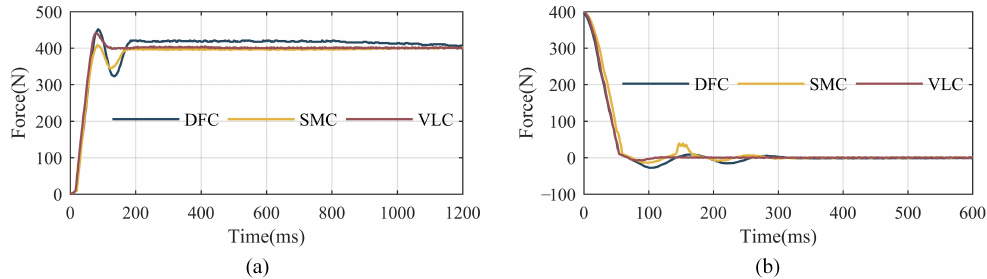
Figure 11. The response curves of step signal with different control strategies. ( a ) Response curves when the target force is 400 N; ( b ) response curves when the target force is 0 N. DFC, SMC, and VLC respectively indicate the direct force-control based on the PID with a DOB, sliding mode control with the DOB mentioned in Section 4, and a cascaded PID control with an inner velocity loop and the DOB mentioned in Section